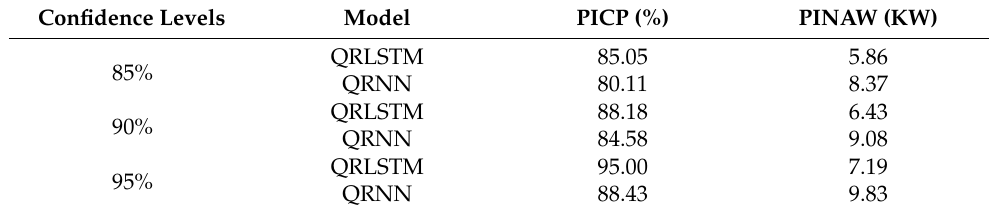
Table 3. Comparison of evaluation indicators on similar-day